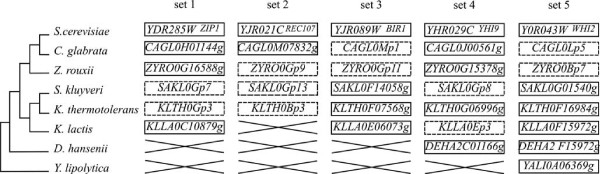
Conserved pseudogenes at syntenic locations. Each column represents a set of orthologous sequences in a region of synteny conservation. Vertical dashed lines separate the different regions. Rectangles represent annotated genes, dashed rectangles represent pseudogenes detected in this analysis. All these pseudogenes have no paralog in the genome. The topology of the species phylogeny [68] is given on the left of the figure (branch lengths ignored).